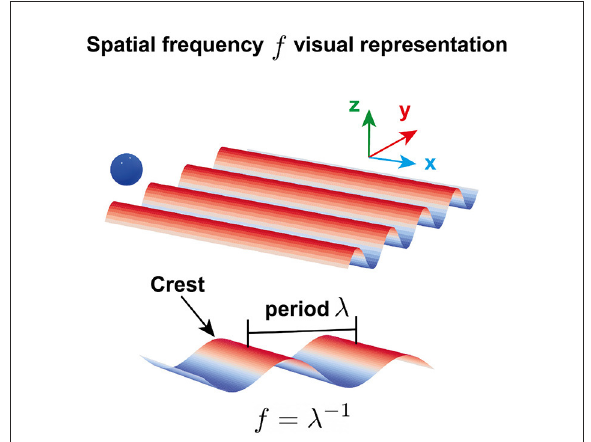
FIGURE2 Visual representation of a virtual sinusoidal grating. Each texture consisted of adjacent crests along the y -axis. The spatial frequency f was defined as the inverse of the spatial period λ , i.e., the distance between two consecutive crests. The blue ball illustrates the position of the robot end effector, y EE , in the virtual environment. The scale and size of the texture and the ball are only for visual purposes and do not represent the scale and size used in the experiment.